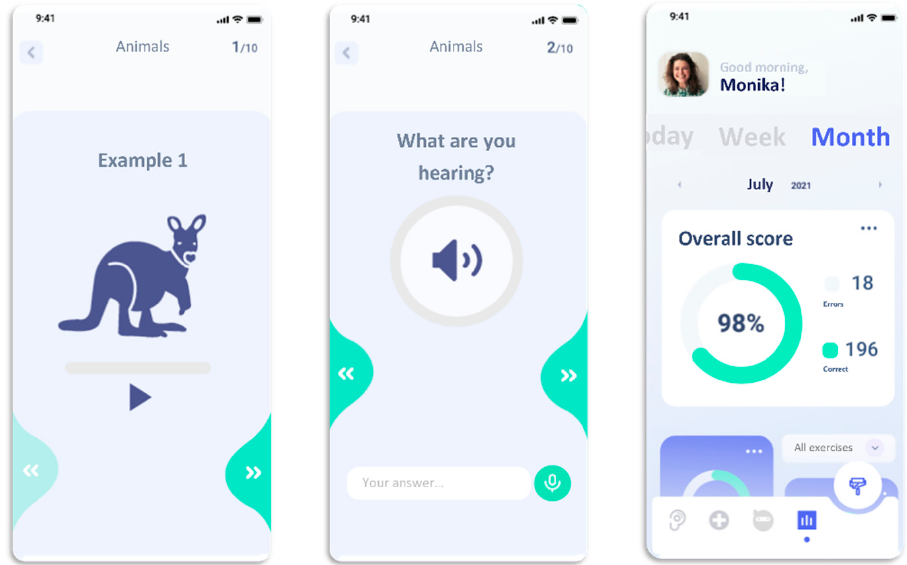
Figure 3. Exemplary illustration of a word exercise (left and middle) and of a performance overview (right).